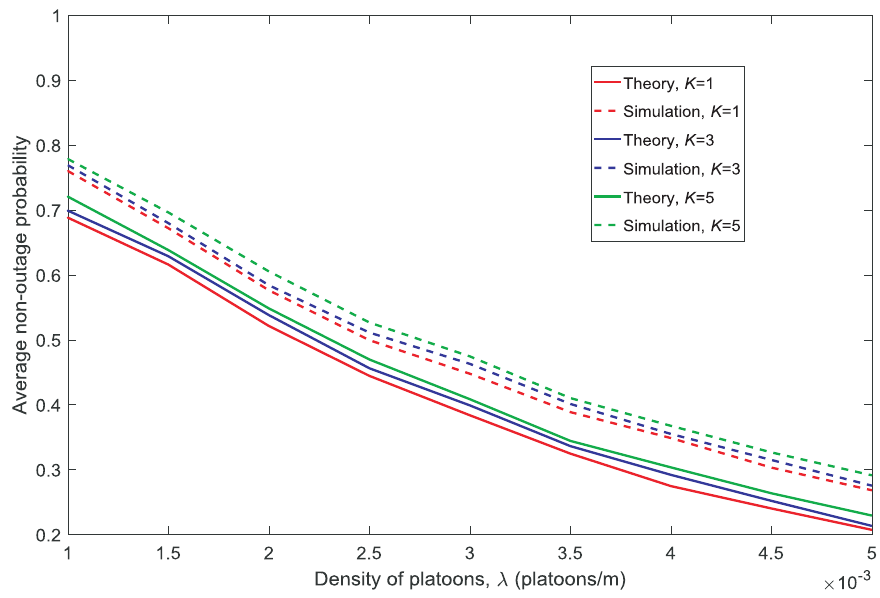
Figure 3. Average non-outage probability for different densities of platoons λ ( d V = 10, V = 10, N = 5 ) .